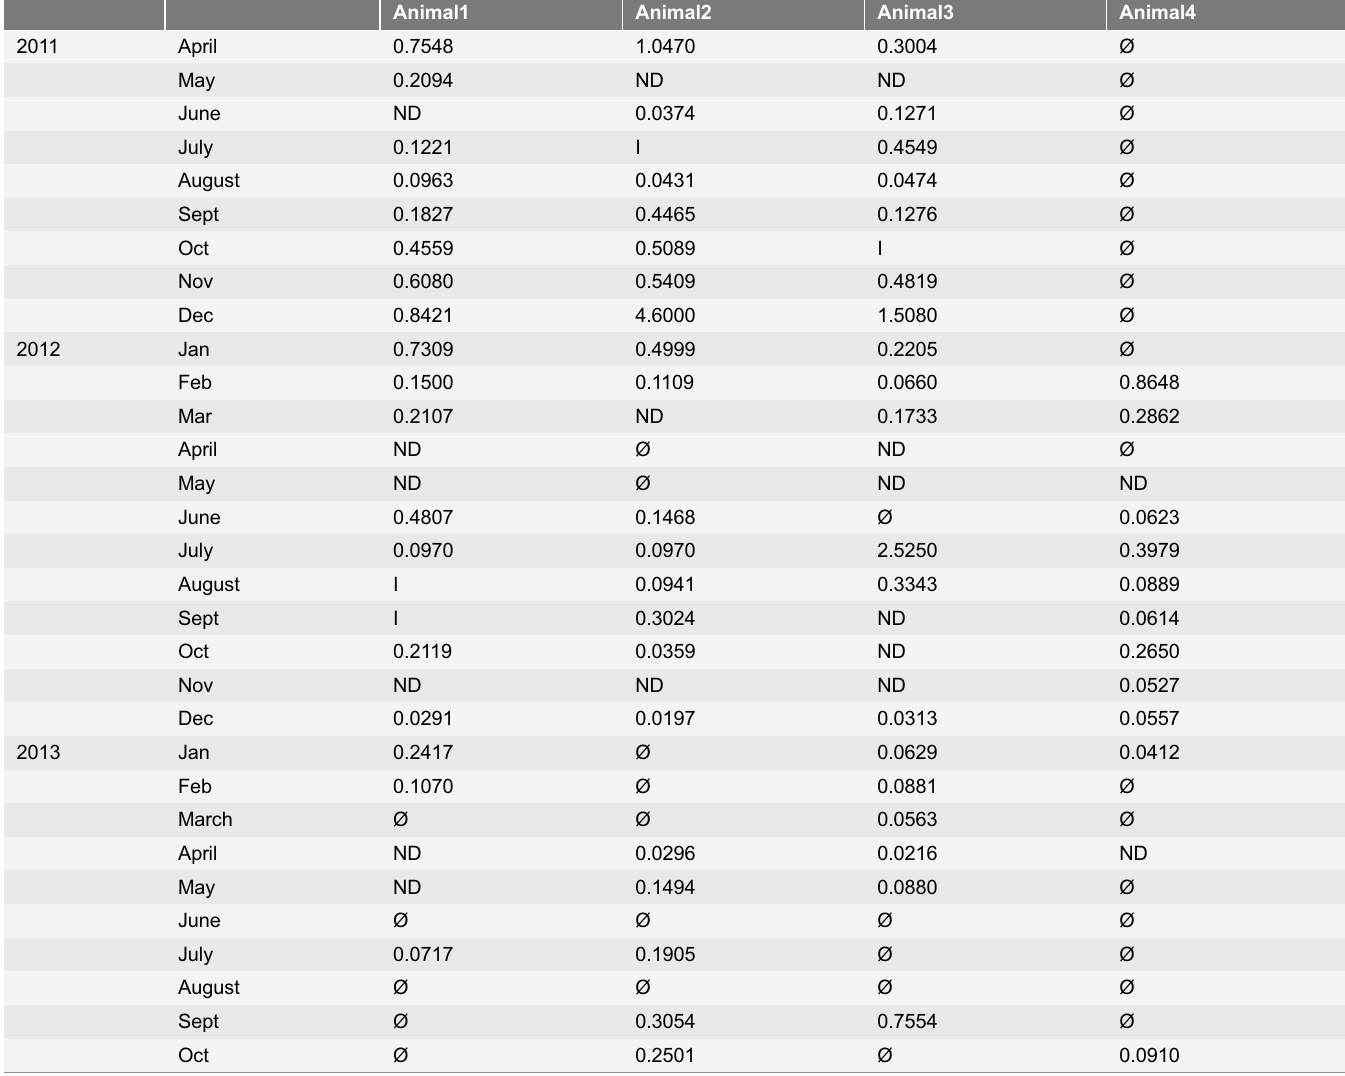
Table 2. Monthly cortisol values of blow for individual animals between 2011 and